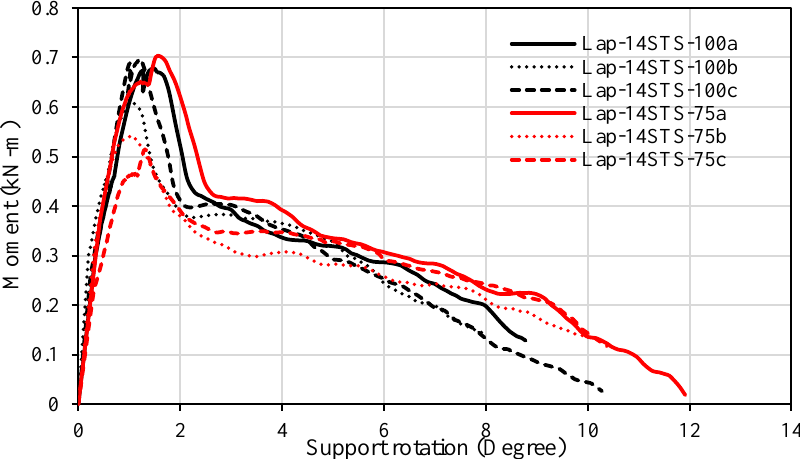
Figure 7. Moment capacity vs. support rotation curves of the screwed lap connections with different lap lengths.